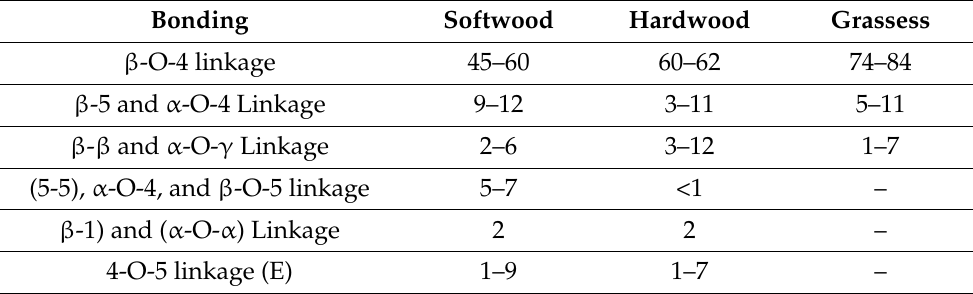
Table 1. Lignin from different sources and different chemical bonding